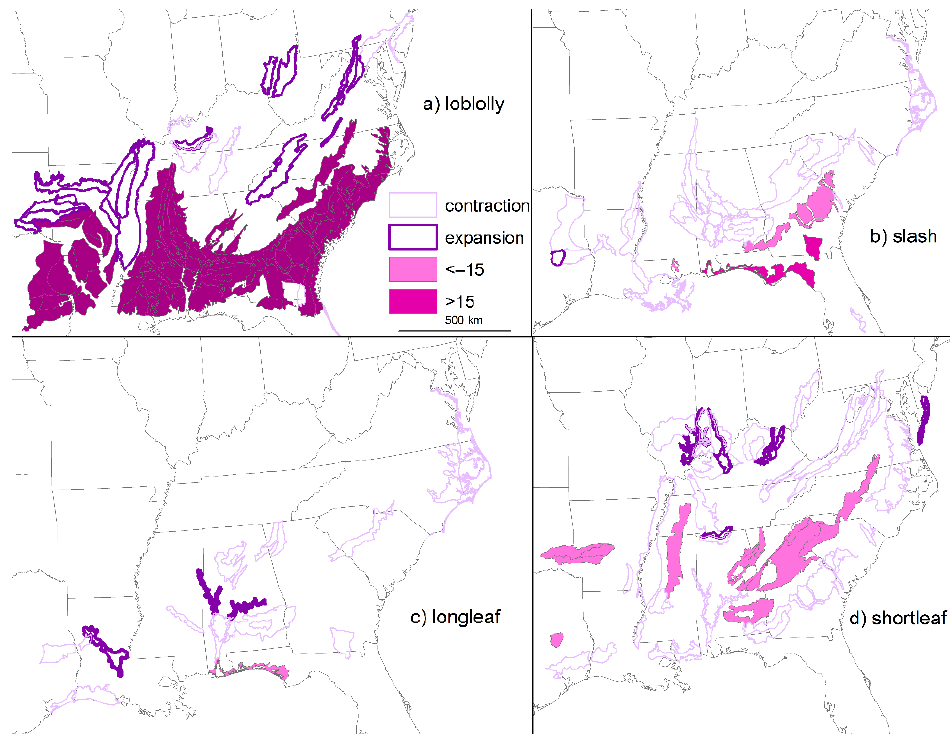
Figure 5. Areas of contraction (thin light purple outline) or expansion (thick dark purple outline) in range (percent composition ≥ 0.5% of all trees in an ecological subsection) and areas of relative decrease by >15 percentage points (pink shading; out of 100 percentage points for composition of all trees) or increase by >15 percentage points (dark pink shading) in ecological subsections for the four pine species. Note that some ecological subsections are discontinuous and comprised of multiple spatial units.